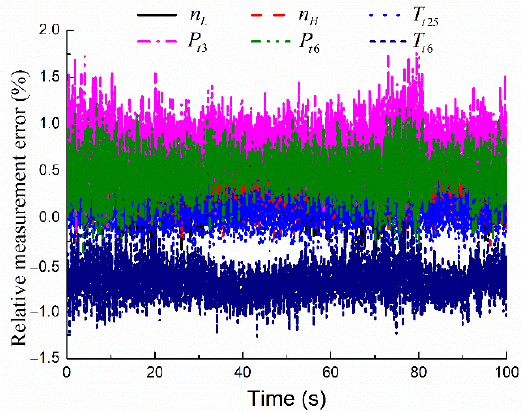
Figure 18. Adapted measurement deviation.